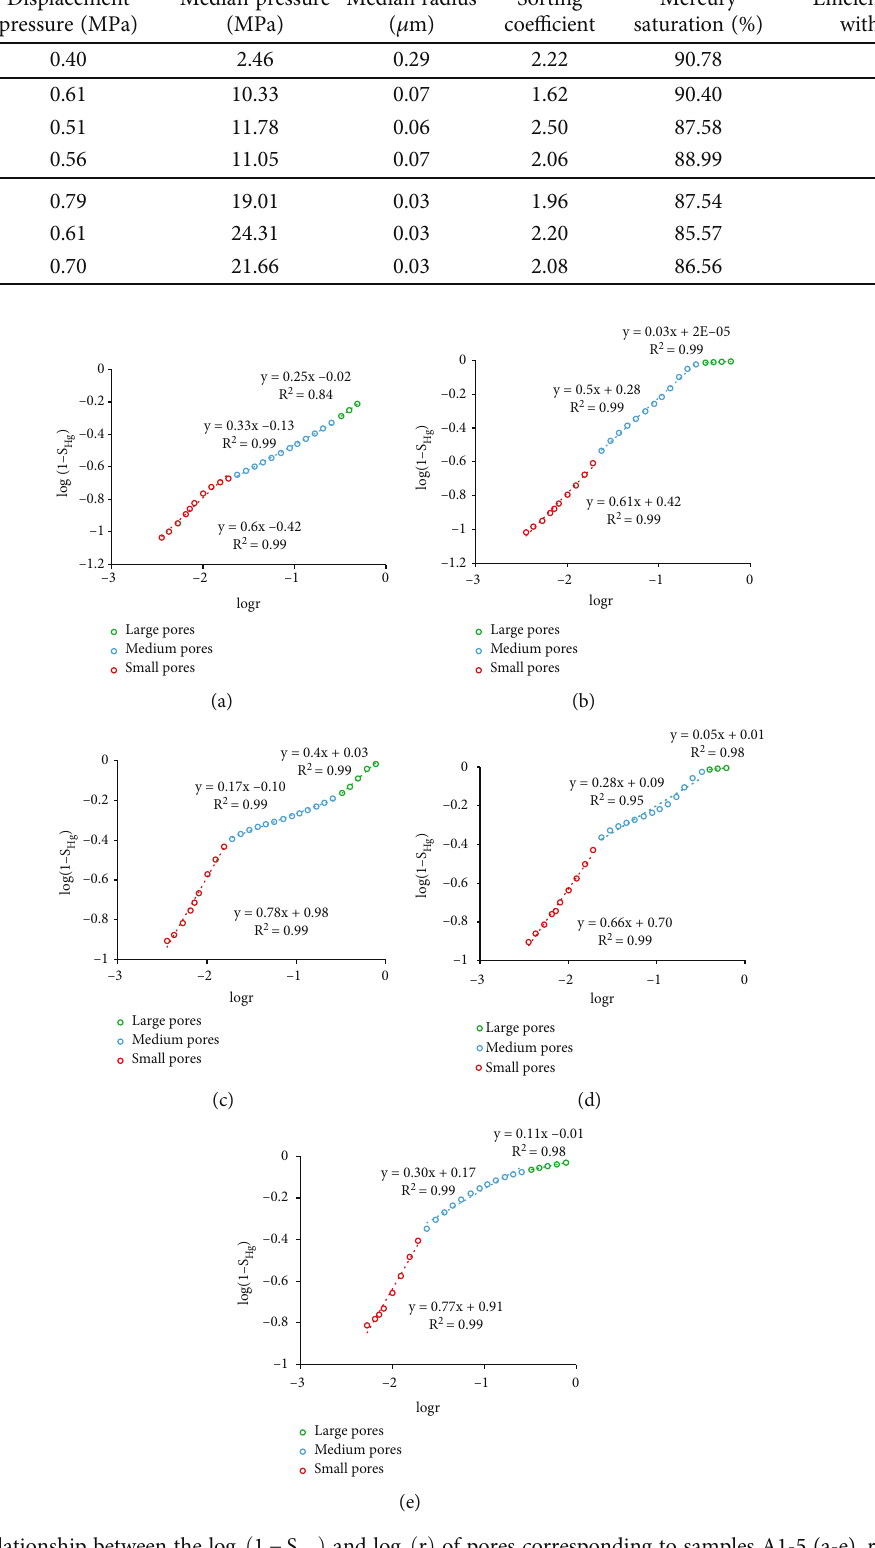
Figure 6: The relationship between the log ð 1 − S